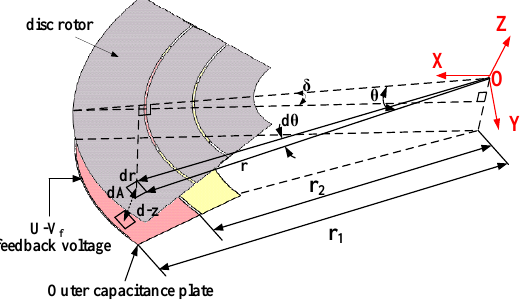
Figure 5. Schematic diagram of disc rotor